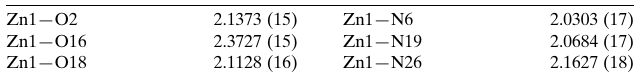
Selected bond lengths (A˚ ).